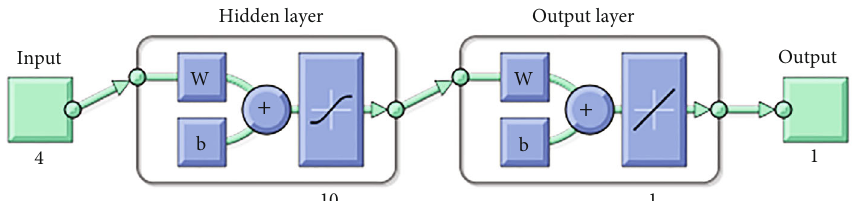
Figure 10: The representation of neural network structure is based on the Tansig transfer function in the hidden layer and the Purelin transfer function in the output layer.